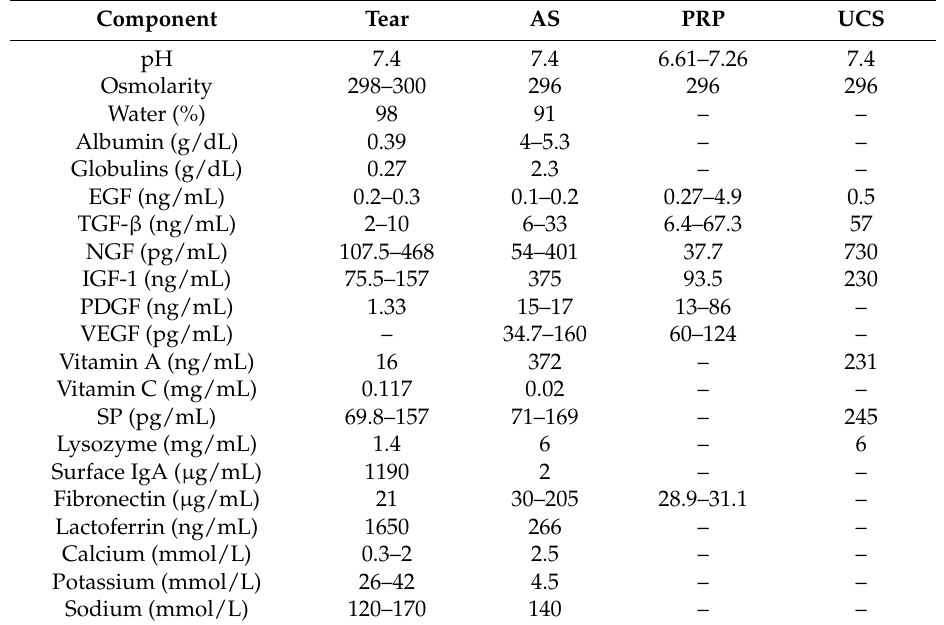
Table 1. Comparison of several components between natural tears and different hemoderivatives used in corneal